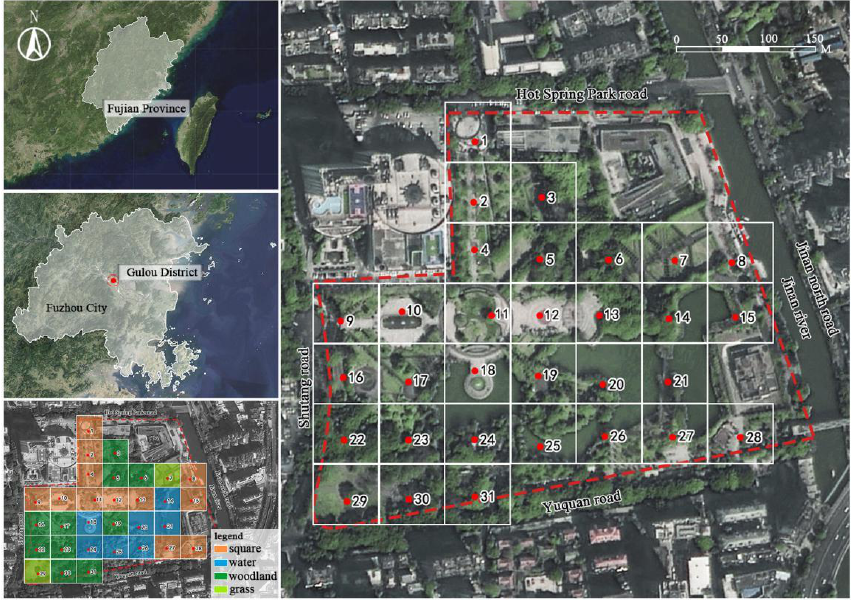
Figure 1. Grid and location of monitoring points (the numbers represent our monitoring points).